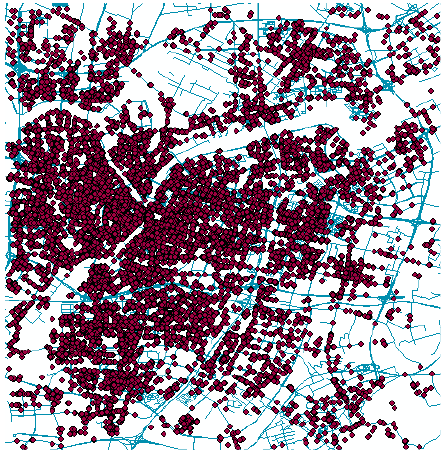
Figure 4. Taxi GPS points of passenger boarding.